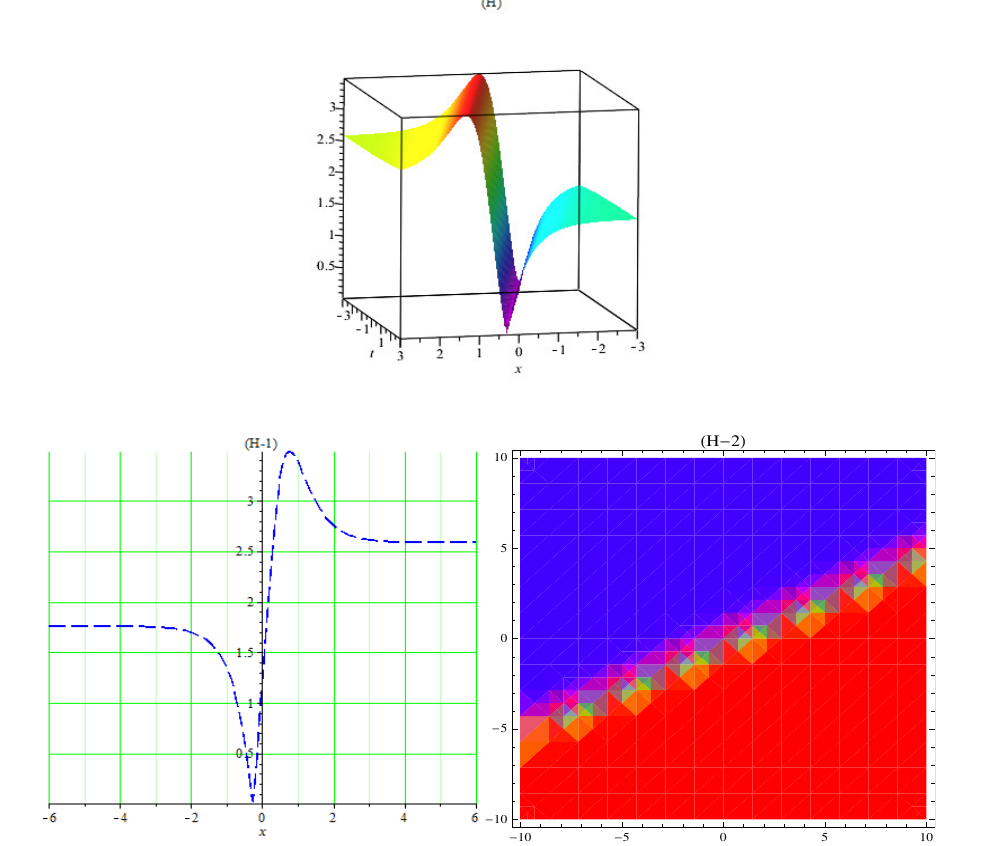
Figure 8. ( H ) 3D graph of dark–bright (55) with l = 2.2, m = 0.4, µ = 0.6, A = 2.7, ζ = 0.5, V = 0.3, λ = 0.6. ( H-1 ) 2D plot and ( H-2 ) contour plot of (55).